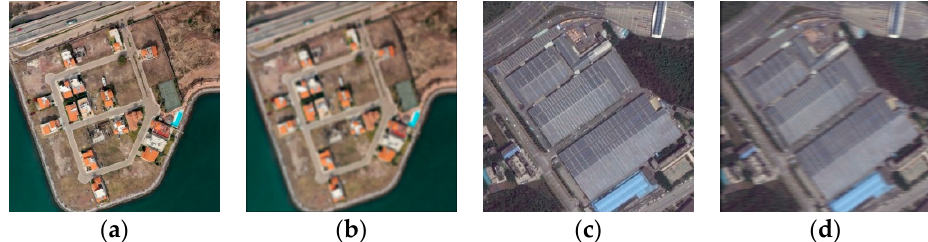
Figure 1. Examples of simulated degraded remote sensing images. ( a , c ) are pristine images. ( b , d ) are distorted by out-of-focus and platform flutter distortions, respectively.